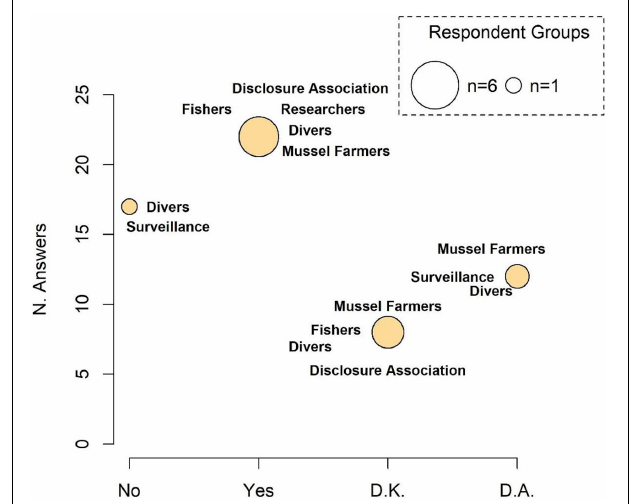
FIGURE 5 | Perception of population density decline in H. guttulatus. The size of the circle is proportional to the number of responding categories. D.K., do not know; D.A., do not answer.